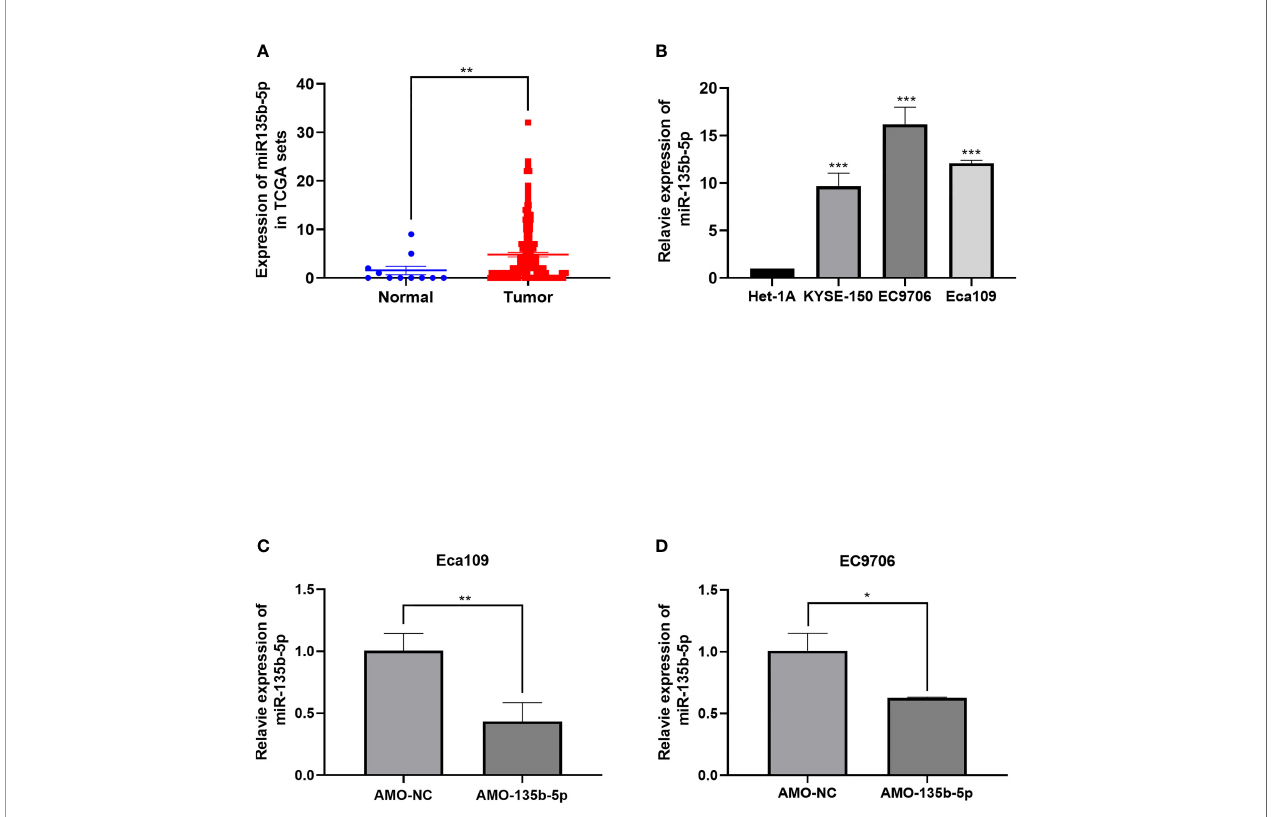
FIGURE 1 | Expression of miR-135b-5p in EC tissues and EC cells. (A) MiR-135b-5p expression was higher in EC patient tissues than normal tissues. (B) MiR- 135b-5p showed higher expression in Eca109, EC9706, KYSE150 cell lines than Het-1A cells. (C, D) Expression of miR-135b-5p with transfected AMO-135b-5p, AMO-NC are showed by real-time PCR. (*p < 0.05, **p < 0.01, ***p <